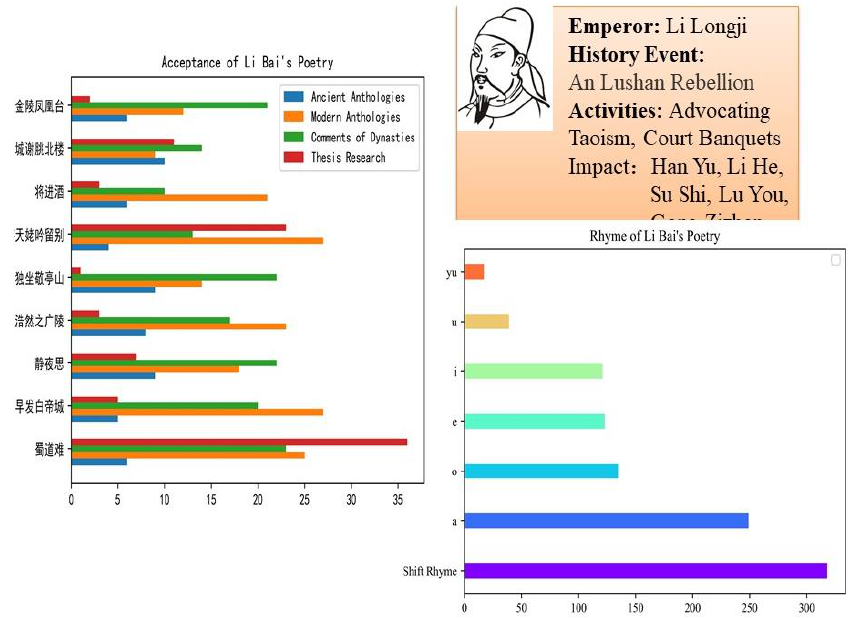
Figure 9. Li Bai profiling for domain knowledge. (The left part represents the title of each poem).